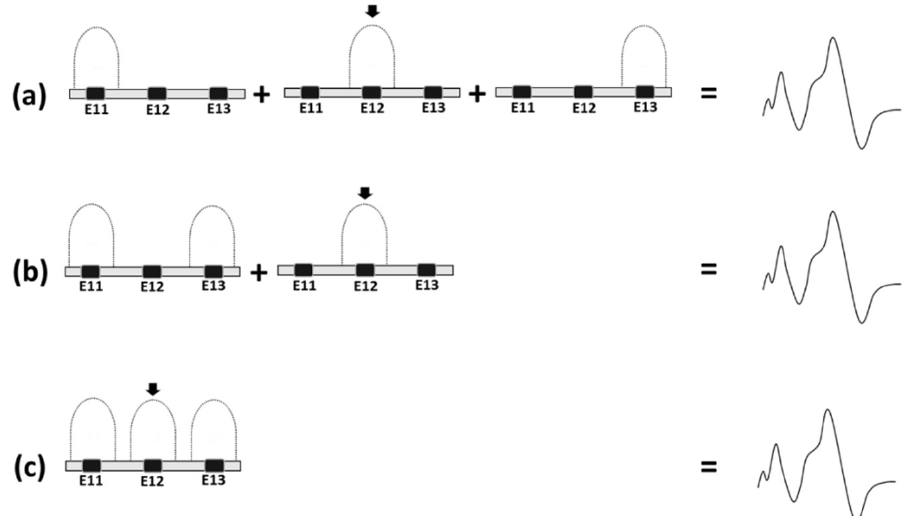
Figure 2. Schematic representation of the eABR manipulations. ( a ) Independent Sum; ( b ) Odd Sequential; and ( c ) Continuous Sequential. Black arrows show the electrode stimulating at varying intensity levels.